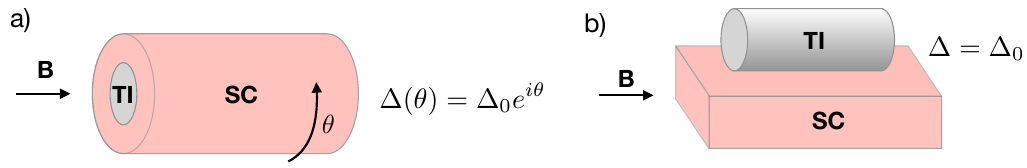
Figure 1: Two simplified setups used to induce the proximity effect in wires in the presence of a magnetic field. In a), the wire is surrounded by a superconducting cylinder, which must itself host a vortex when the flux is h / 2 e . The TI then inherits the vortex profile in proximity-induced pairing field. In b), the wire is only partially contacted by the bulk superconductor. In the limit where the superconductor is a thin film no vortices are expected, and the induced pairing in the wire will be ap- proximately